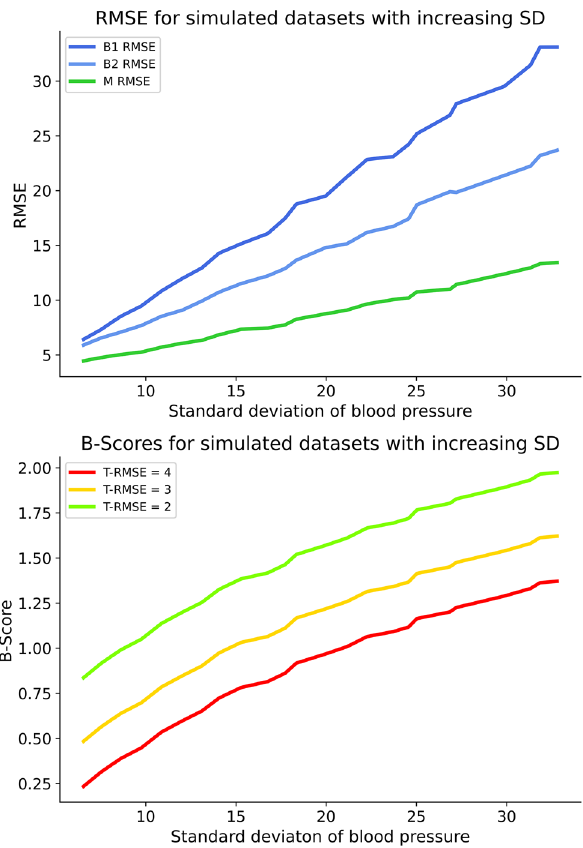
Figure 4. Base performances and B-Scores plotted against increasing standard deviations of simulated datasets. The upper panel shows rising base performance values (B1-, B2- and M-RMSE) for increasing standard deviation. Accordingly, the lower panel shows increasing B-Scores for constant T-RMSE values and increasing standard deviation. The B-Score discriminates between three tested T-RMSE